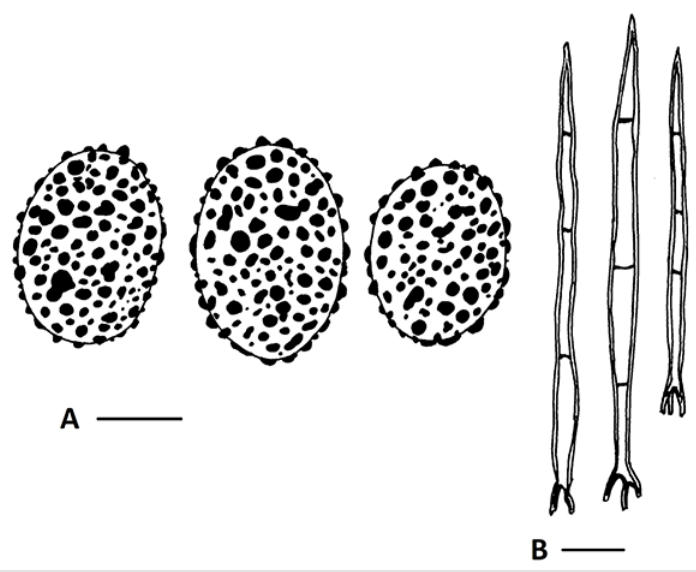
Fig. 2 Microcharacters of Scutellinia patagonica (Rehm) Gamundí. ( A ) spores; ( B ) marginal hair. Scale bars: 10